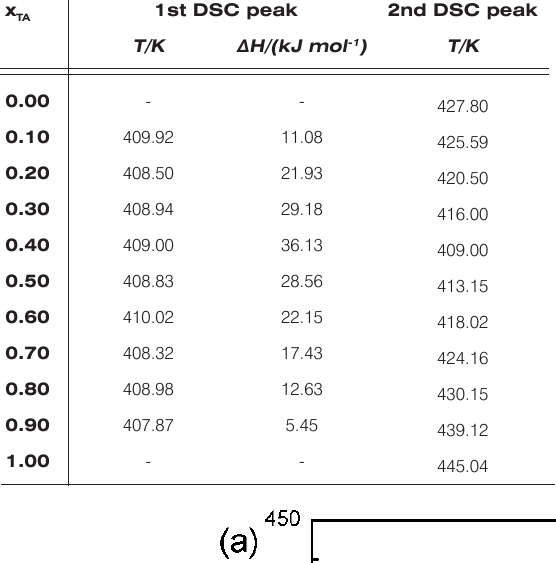
Table 2. Melting temperature and enthalpy of the binary system citric acid / tartaric acid.